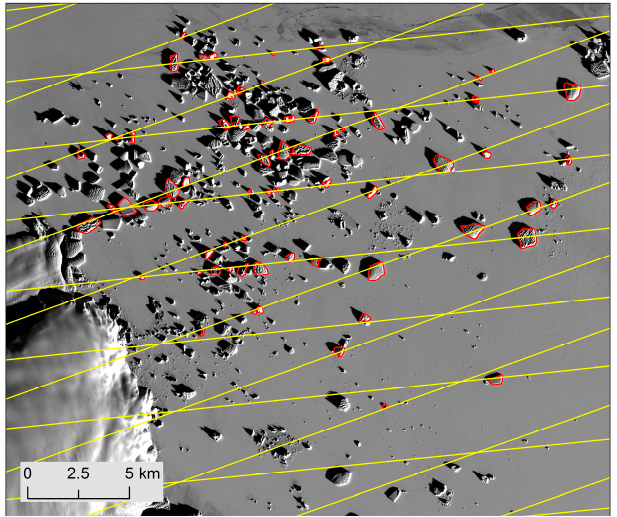
Figure 8. The 76 icebergs (red polygons) tracked by all the ICESat-2 repeated orbits (yellow lines) overlaid on the Landsat-8 image taken on 29 August 2016 in the study area.